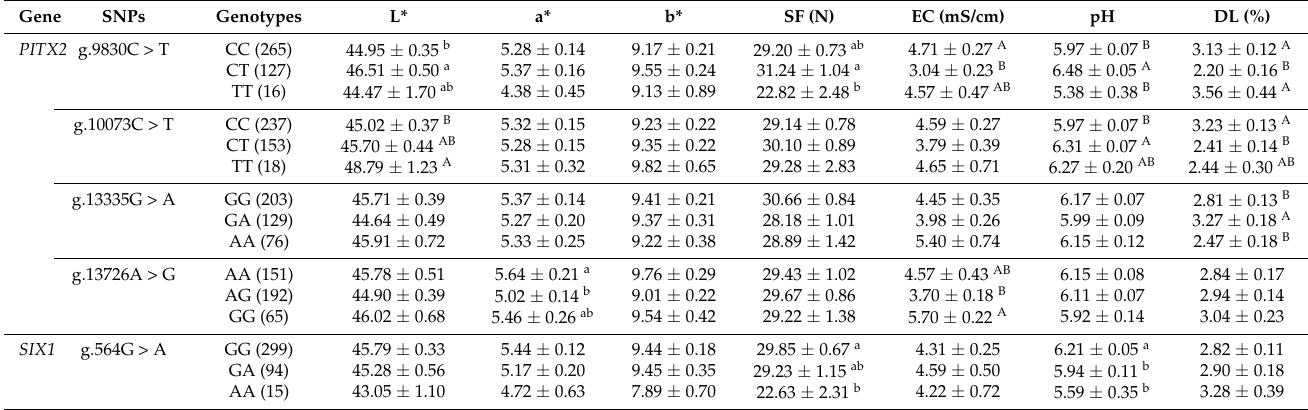
Table 3. Association of SNPs of PITX2 and SIX1 gene with meat quality traits in Wulang Mountain Black-bone chickens (MEAN ± SE).